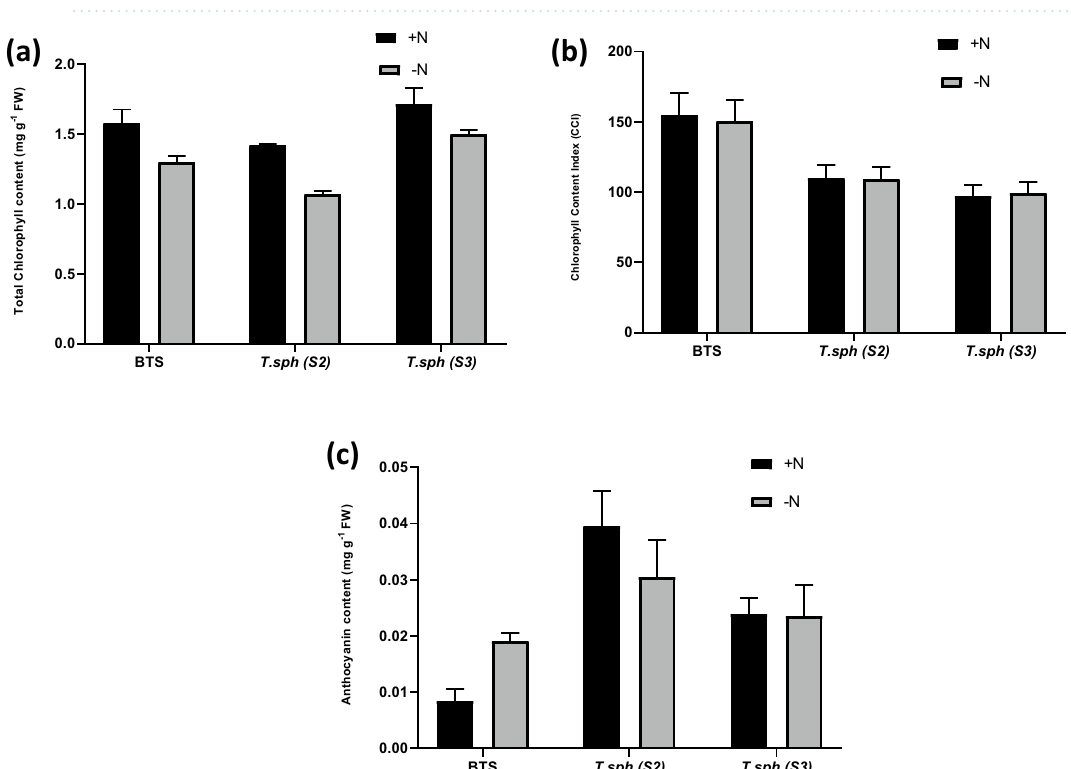
Figure 3. Effect of nitrogen deficient (0.05 mM nitrate, N−) and nitrogen sufficient (7.5 mM nitrate, N+) conditions on total chlorophyll content ( a ) CCI ( b ) and anthocyanin content ( c ) of thirty days old seedlings of wheat genotypes grown under hydroponic